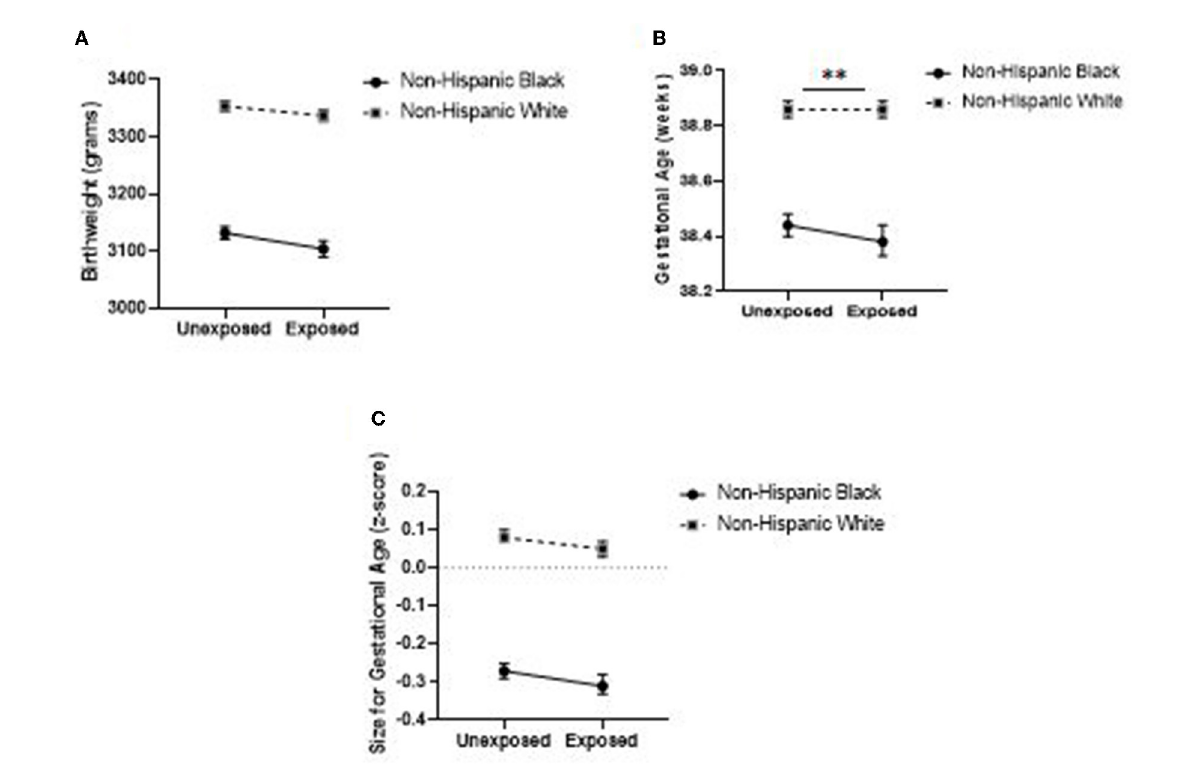
FIGURE1 Adjusted means for birthweight (A) , gestational age (B) , and size-for-gestational-age (C) by maternal race and exposure to the Flint Water Crisis emergency declaration in Michigan ( n = 226,672). Asterisks (**) denote statistical significance of the race-by-exposure interaction at α = 0.05. Means are from fully adjusted models.